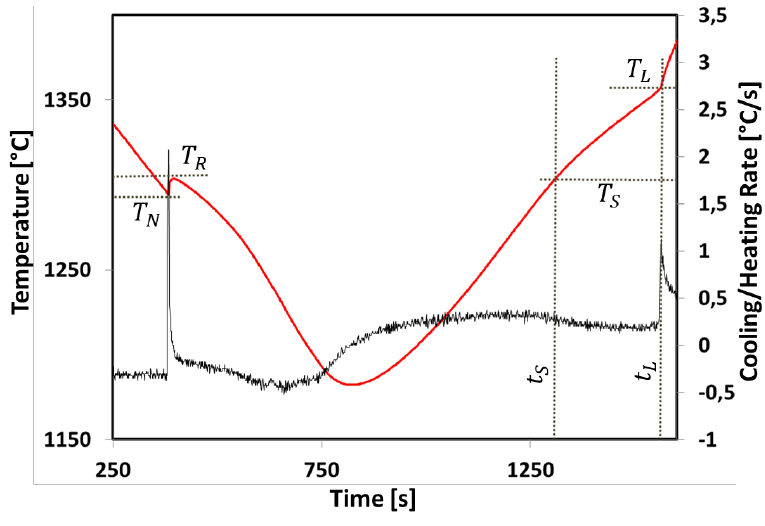
Figure 8. Measurement of the undercooling in one cooling and heating